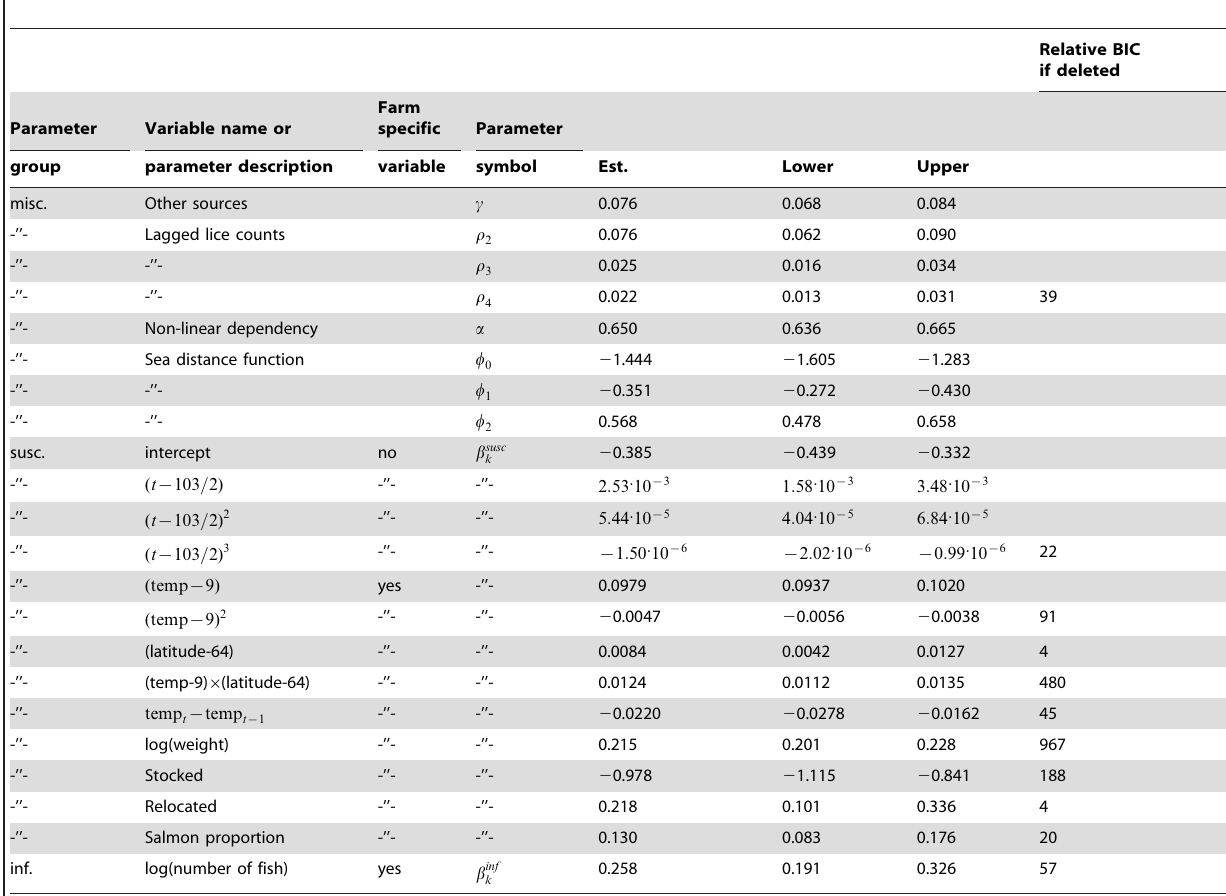
with 95% confidence intervals for the selected model, with it